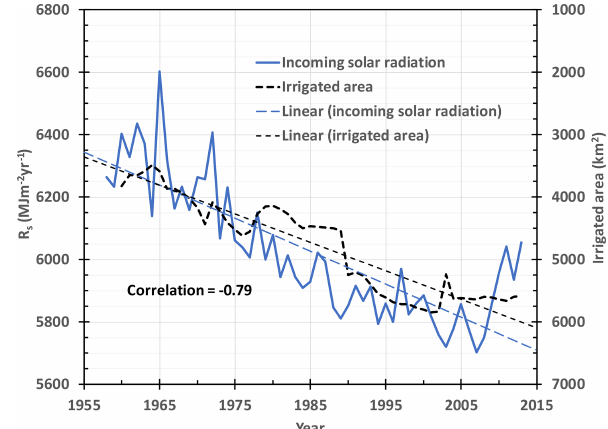
Figure 8. Comparison between annual potential evaporation esti- mated from Eq. (5) and the area weighted annual pan evaporation for Hetao over the period 1958 to 2013. The linear temporal trends are not